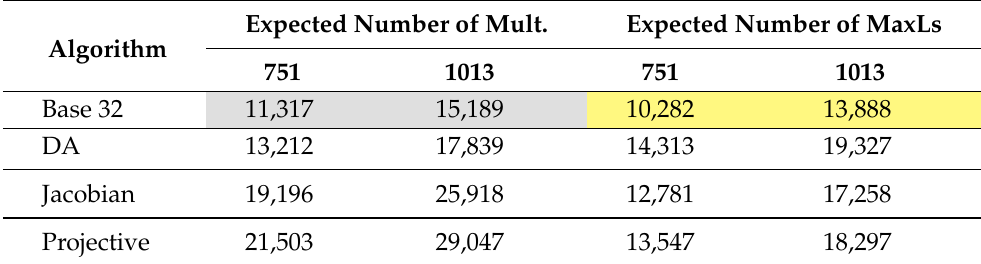
Table 6. Expected number of Multiplications and Maximum Levels with Key of Sizes 751 and 1013.